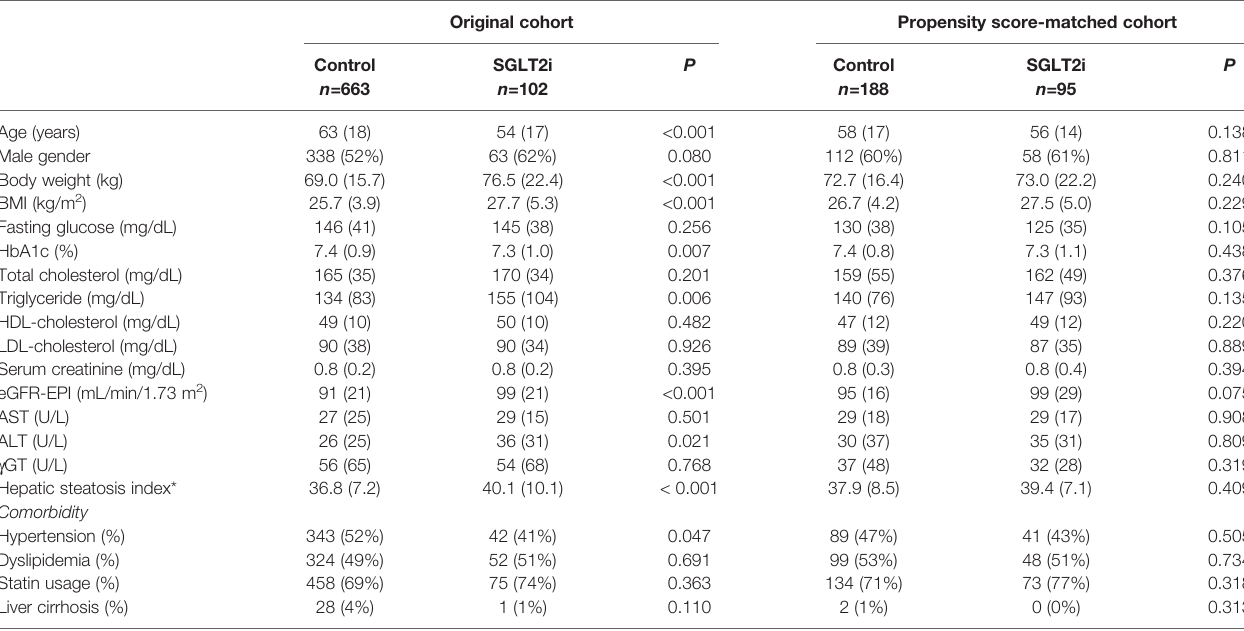
TABLE 1 | Baseline characteristics of the study population.